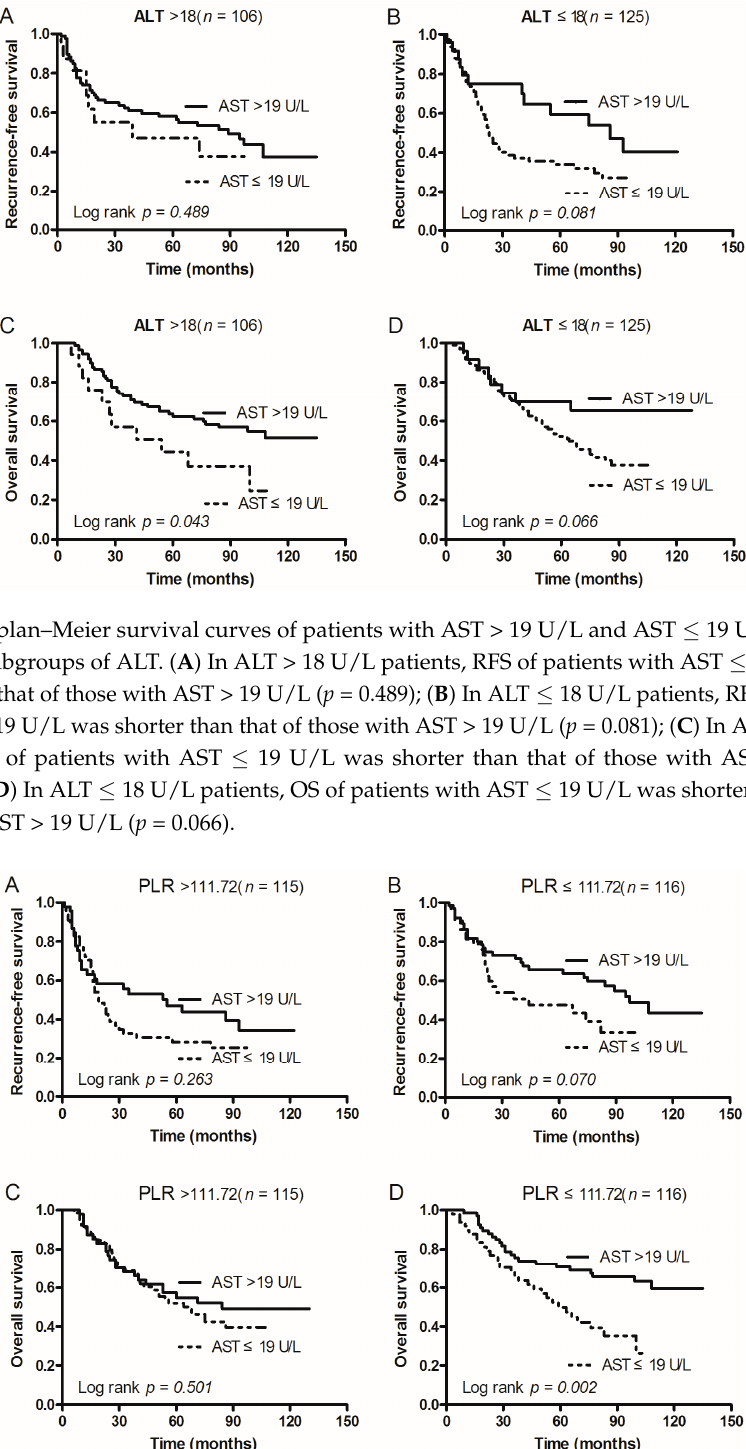
than that of those with AST > 19 U/L ( p = 0.255); ( B ) In size ≤ 4 cm patients, RFS of patients with AST ≤ 19 U/L was shorter than that of those with AST > 19 U/L ( p = 0.044); ( C ) In size >4 cm patients, OS of patients with AST ≤ 19 U/L was shorter than that of those with AST > 19 U/L ( p = 0.476); ( D ) In size ≤ 4 cm patients, OS of patients with AST ≤ 19 U/L was shorter than that of those with AST > 19 U/L ( p = 0.016).